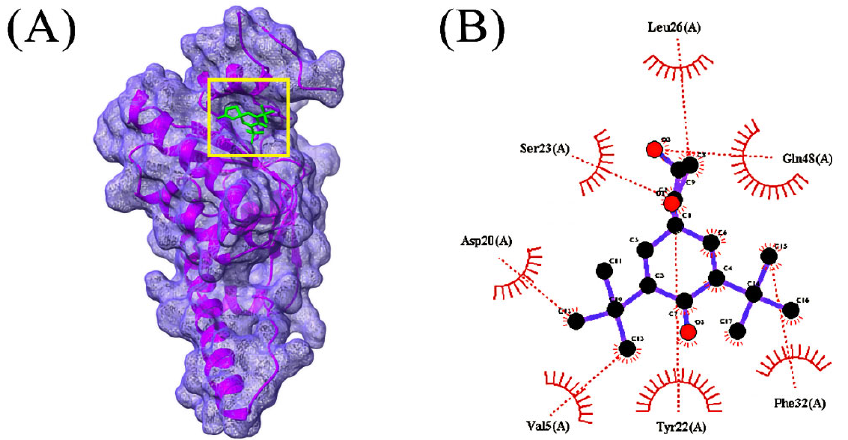
Figure 7. Docking simulation between protein-ligand interactions of Caseinolytic proteases (Clp) enzymes Bacillus subtilis (PDB ID: 7M1M) and 2,2’-anhydro-1-arabinofuranosyluracil, where ( A ) Surface